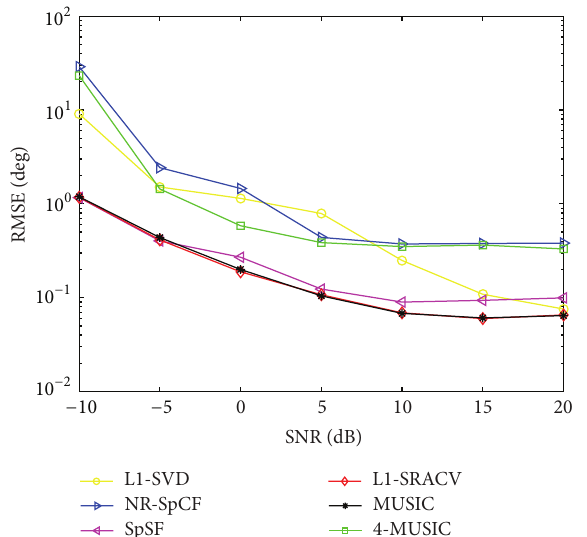
Figure 3: RMSE versus SNR for the six methods in Gaussian white noise case. 𝑀 = 6 , 𝑄 = 2 , and 𝑇 = 1000 .